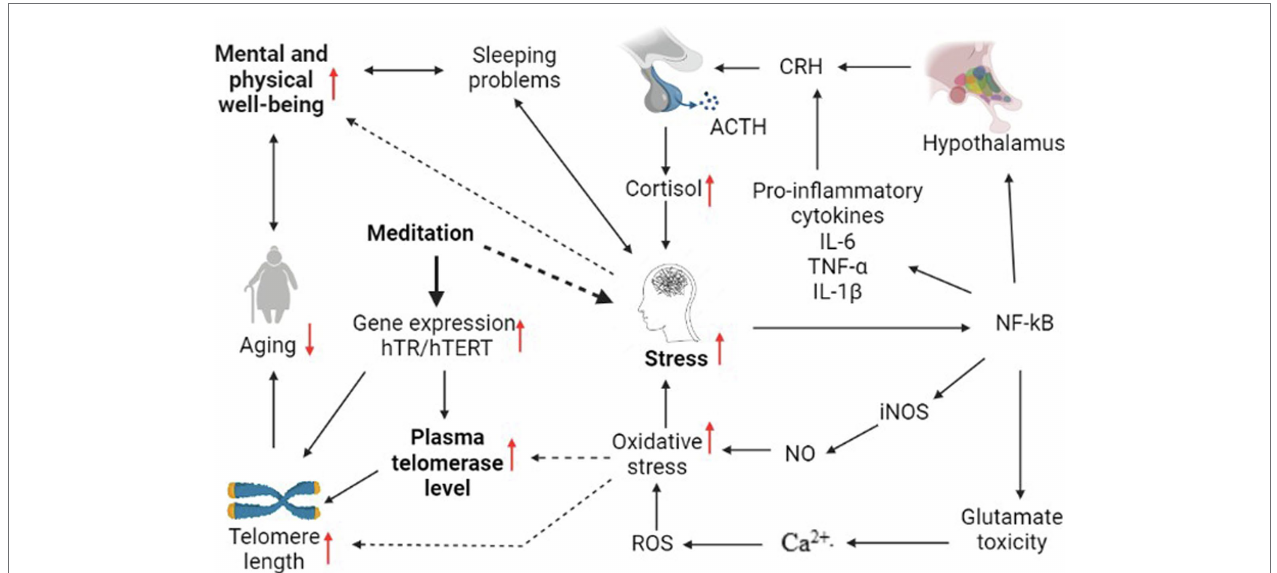
FIGURE 1 | Schematic diagram of hypothesized biological pathway of the effects of meditation on mental and physical wellbeing and aging. NF-kB-Nuclear Factor kappa B; CRH-Corticotrophin-Releasing Hormone; ACTH-Adrenocorticotrophic Hormone; IL-6-Interleukin-6; TNF- α -Tumor Necrosis Factor-alpha; IL-1 β - Interleukin-1 Beta; Ca 2+ -Caylcium; ROS-Reactive Oxygen Species; iNOS-inducible Nitric Oxide Synthase; NO-Nitric Oxide; and ---> Inhibitory effect. The production of ROS and iNOS which is triggered by an internal/external stressor, increases oxidative stress, which in turn reduces plasma telomerase enzyme level and telomere length (Saretzki, 2009; Fouquerel et al., 2016). Decreased telomere length is associated with rapid aging (Vaiserman and Krasnienkov, 2021). The Hypothalamic Pituitary Adrenal (HPA) axis is activated when the brain perceives a stressor and as a result cortisol is released. Increased cortisol and oxidative stress cause physical and mental stress (Kasala et al., 2014). Stress also has a negative effect on mental and physical wellbeing (Rector et al., 2016). Meditation can improve wellbeing and mindfulness by reducing stress and thus, reduce aging (Chételat et al., 2018). Meditation promotes the expression of the hTERT gene, which encodes for a component of telomerase enzyme. Plasma telomerase acts on the telomeres and maintains its length. Meditation also promotes the expression of hTR gene which provides a template for the production of the repeated sequence tracts on telomeres (Buric, 2017) and reduces the shortening of telomere lengths which in turn delays cellular aging (Figure created with